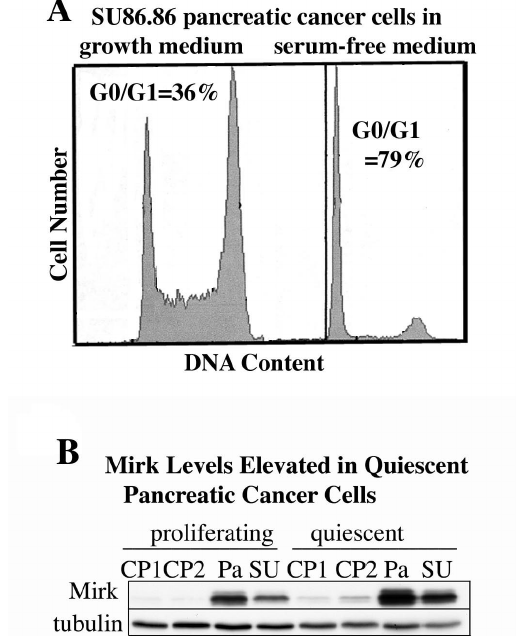
Figure 4. Mirk levels are elevated in quiescent pancreatic cancer cells. ( A ). SU86.86 cells were cultured for 48 h in medium containing either 7% fetal calf serum to maintain proliferation, or no serum mitogens to induce quiescence, then analyzed for cell cycle position by flow cytometry after staining with propidium iodide. ( B ). Panc1 (Pa), SU86.86 (SU), Capan1 (CP1), and Capan 2 (CP2) were cultured as in A before Western